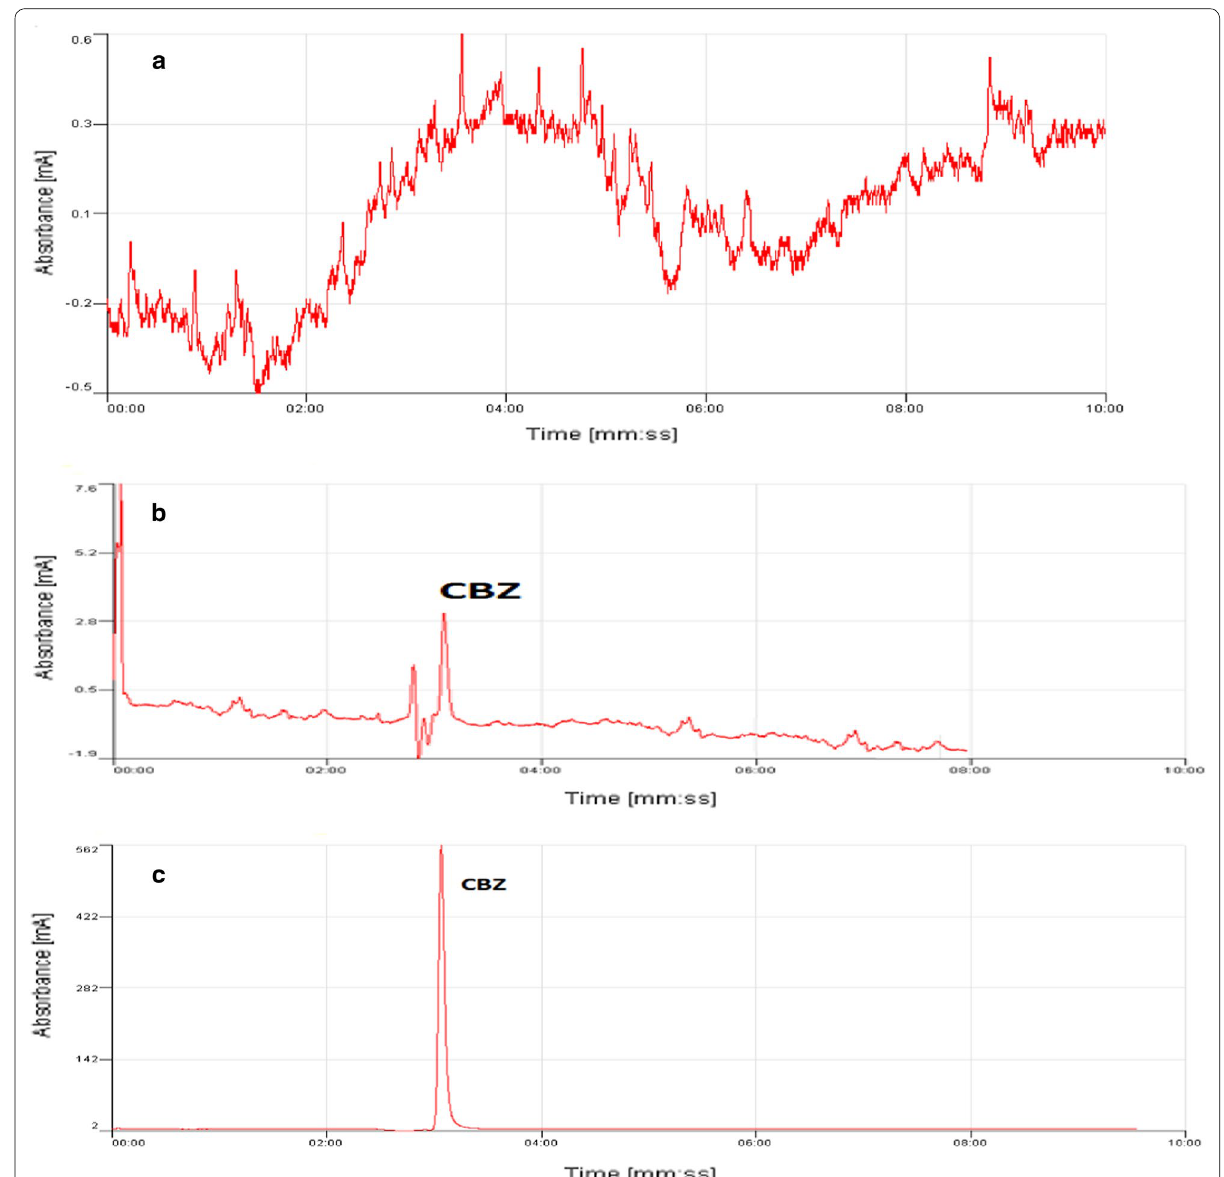
Fig. 10 Chromatograms obtained for the analysis of carbamazepine; a direct injection of urine sample, b direct injection of urine sample spiked with 50 µg L − 1 of CBZ, and c injection of spiked urine sample with 50 µg L − 1 of CBZ after PT-SPE